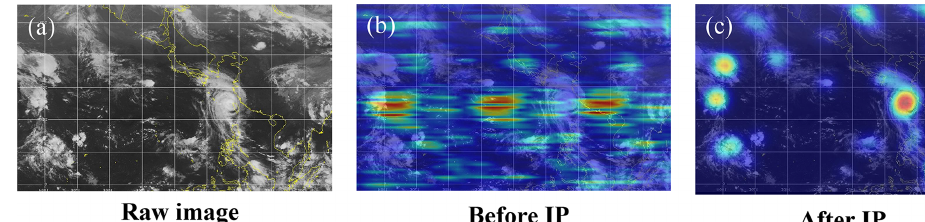
Figure 12. Heat map before and after using IP.